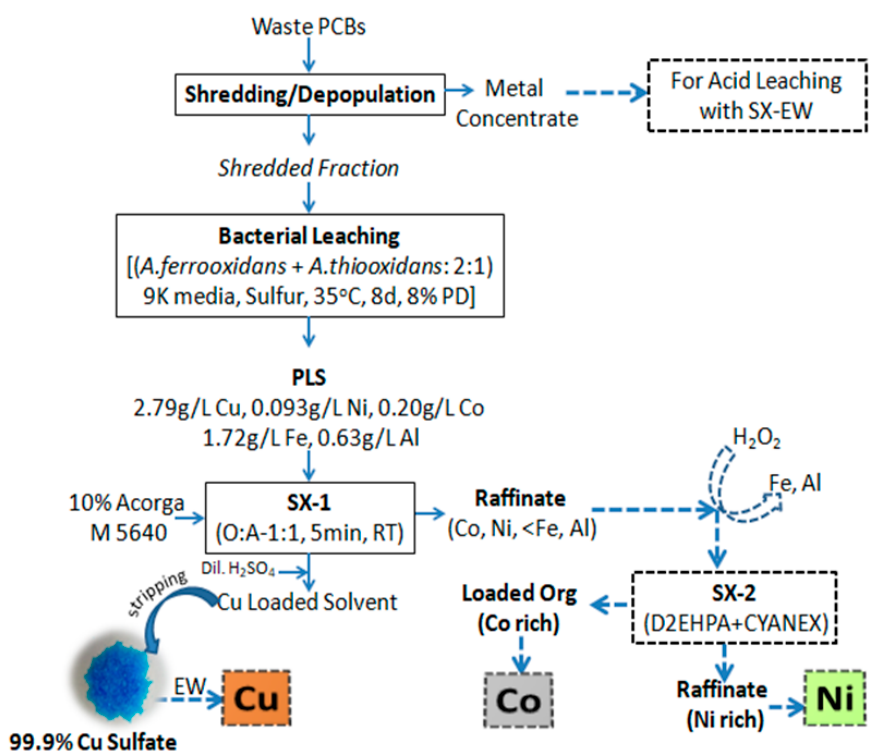
Figure 15. Process flowsheet for bio-recycling of depopulated shredded PCBs to extract copper.